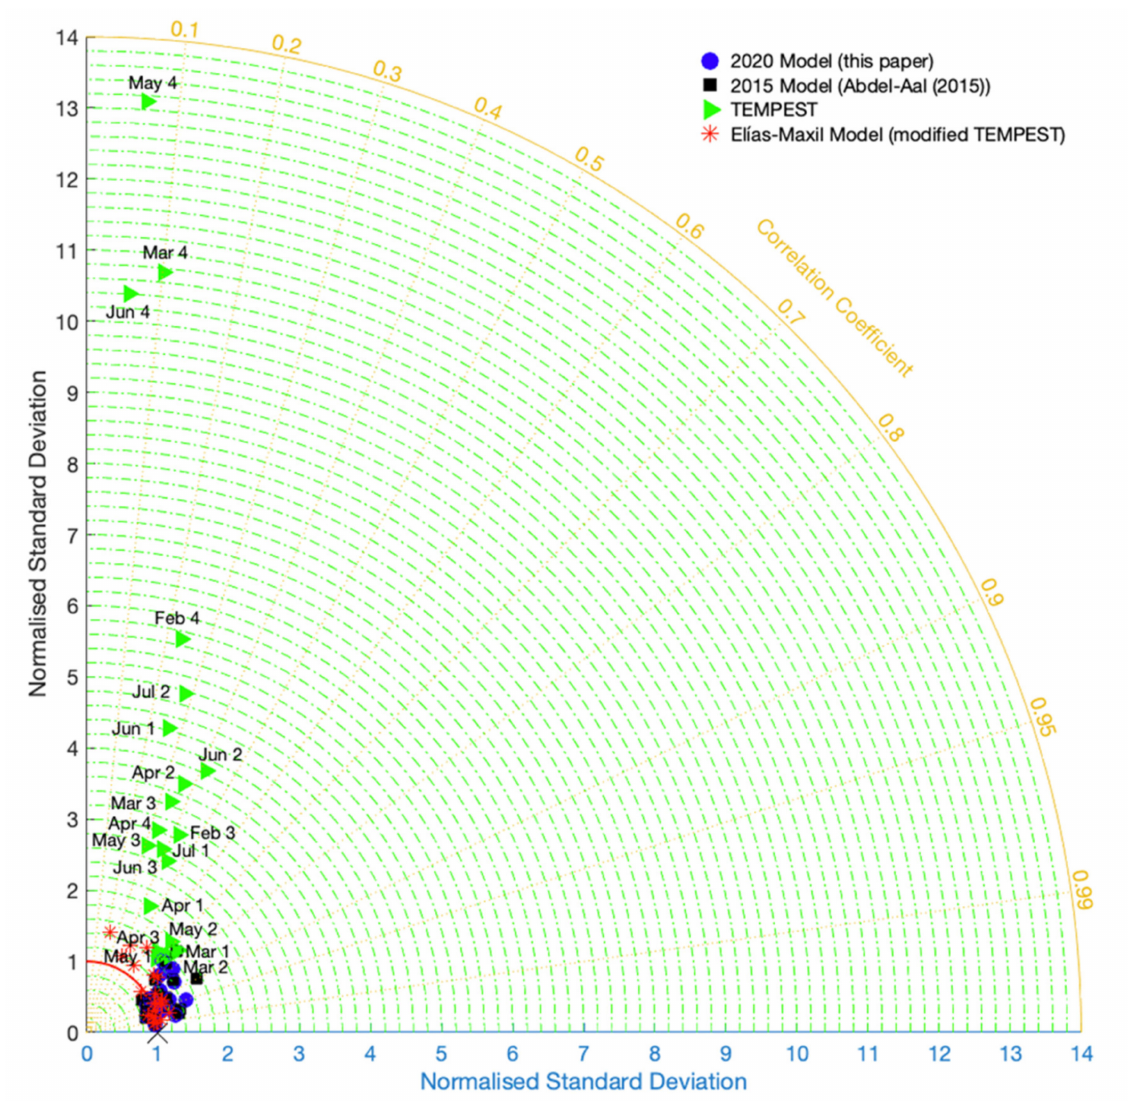
Figure 11. Taylor diagram for modelled wastewater temperatures at downstream ends at all sites using 2020, 2015, TEMPEST and El í as-Maxil